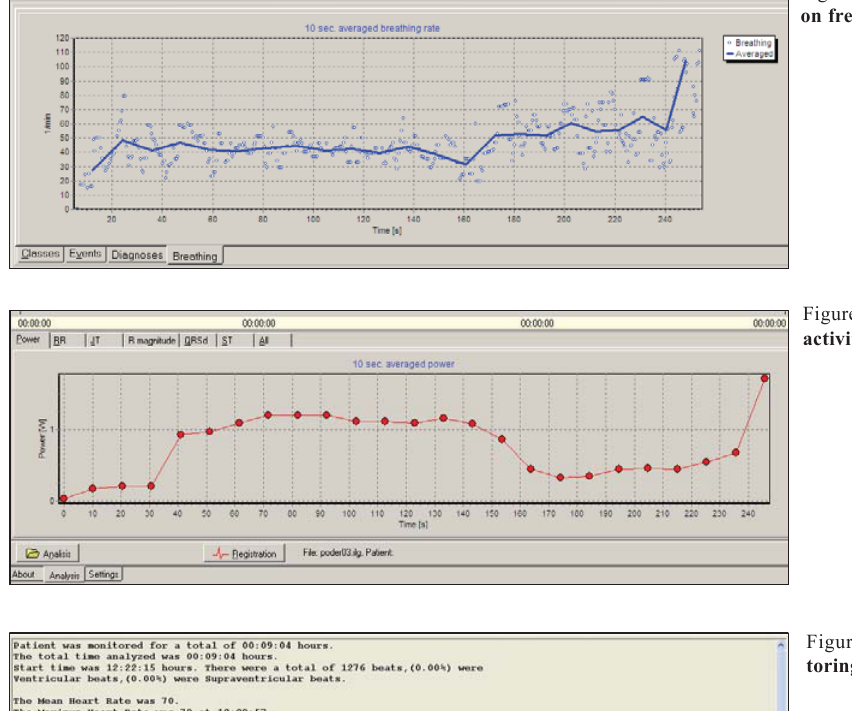
Figure 8. Final report of athlete’s moni-